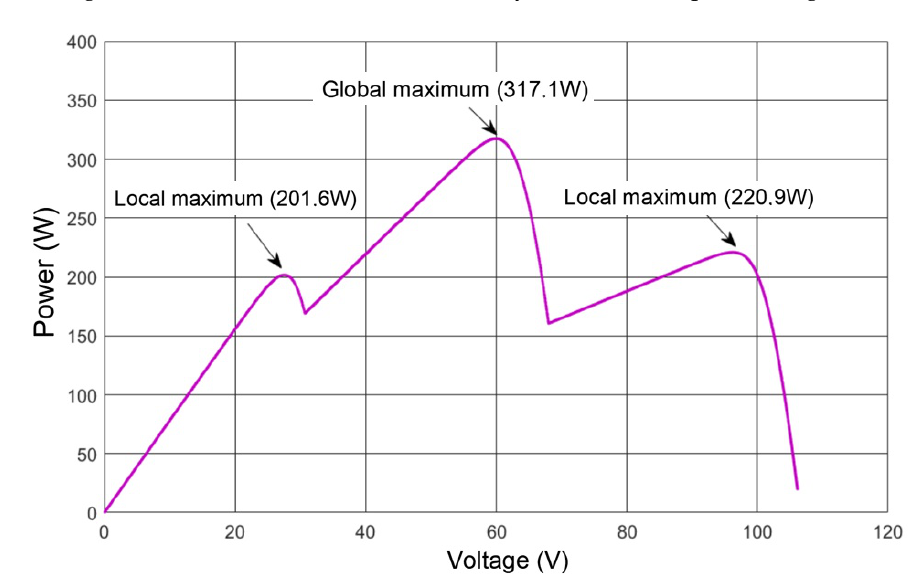
Figure 13. P-V characteristic curve of the PV array with partial shading of Step